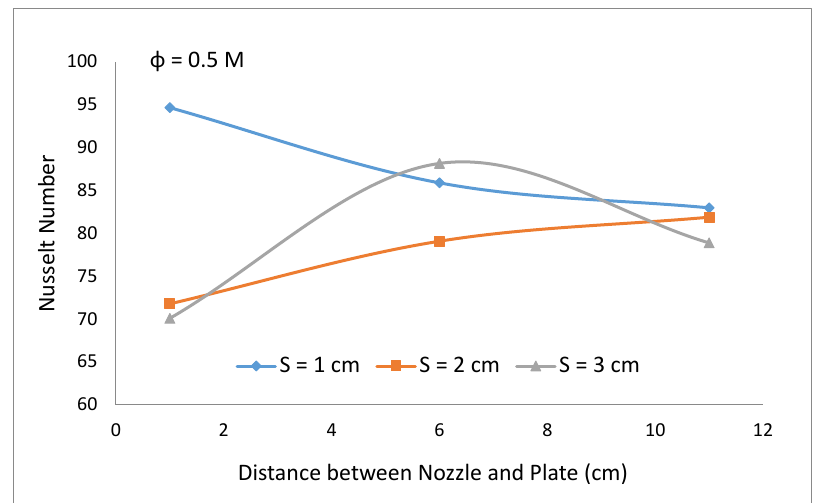
Figure 19. Interaction of nozzle-plate distance and nozzle-nozzle spacing levels at optimum levels of other factors. Figure 20. Interaction of Nusselt number and Reynolds